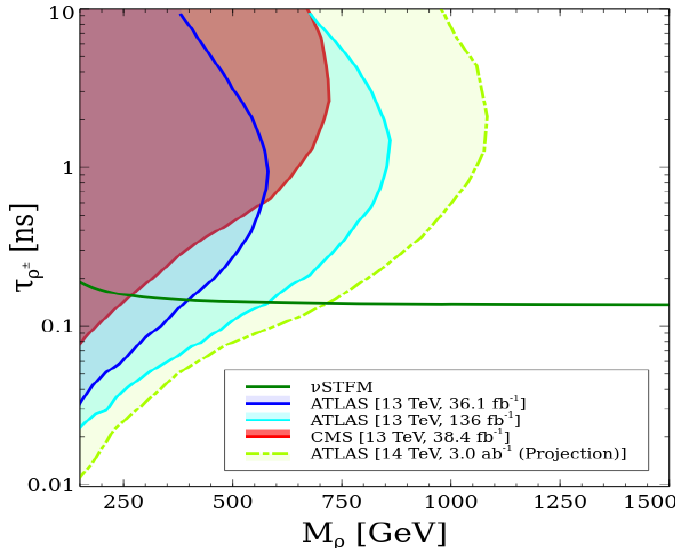
Figure 2 . Blue(light) and red(dark) shaded regions show the bound on the DM mass from AT- LAS [18, 19] and CMS [20] detectors at LHC collider from disappearing charged track, respectively. The light green dot dashed line represents the projection for HL-LHC [21].